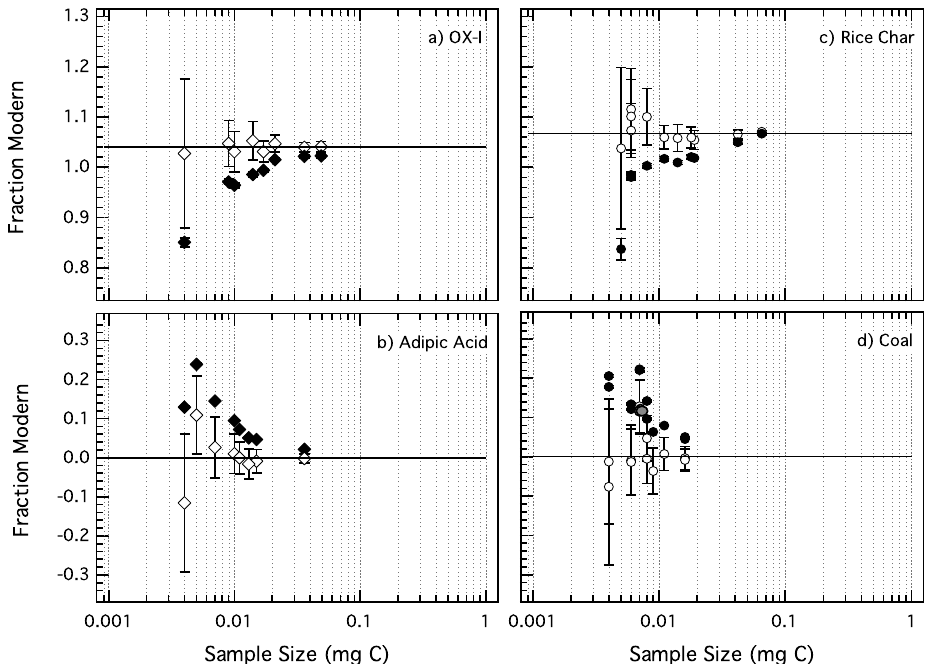
Figure 3. Background correction for OC standards (left panels: (a) OX-I and (b) adipic acid) and EC standards (right panels: (c) rice char and (d) coal). Black symbols represent the measured 14 C content of each standard prior to background correction. The white symbols show the 14 C content for each standard after background correction was applied. Horizontal lines show the consensus 14 C content, expressed as fraction modern ( f M ) for each standard. The top panels show the modern reference materials used to quantify the fossil contamination, while the bottom panels show the 14 C-free blanks used to quantify the modern contamination. Note that the gray circle in panel (d) represents a coal sample after background correction, which was excluded from the calculation of the modern blank as an outlier.